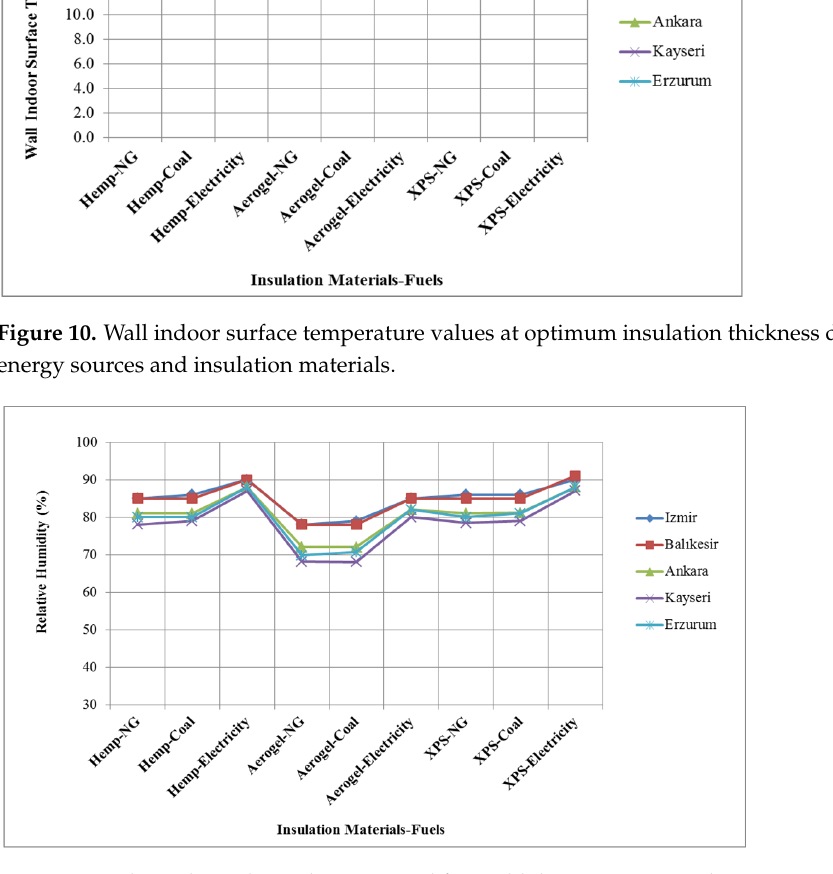
Figure 12. The highest moisture content for the optimum insulated wall was calculated